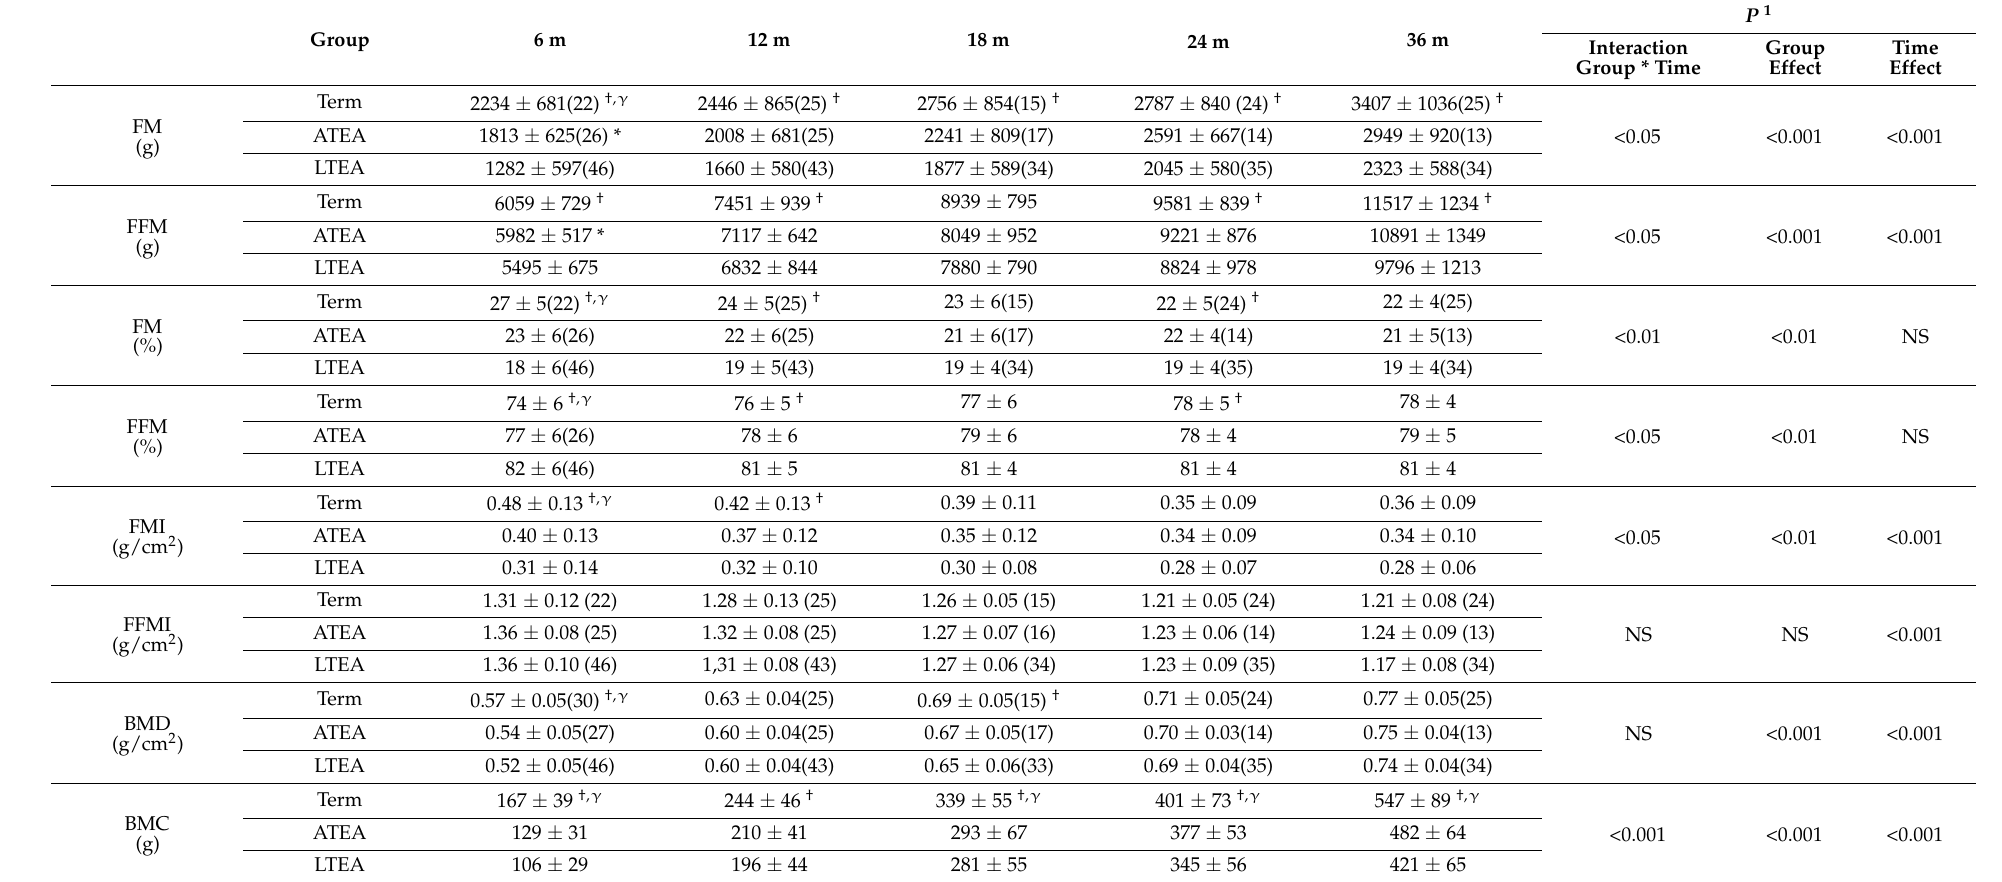
Table 4. Body composition and bone densitometry results (by dual-energy X-ray